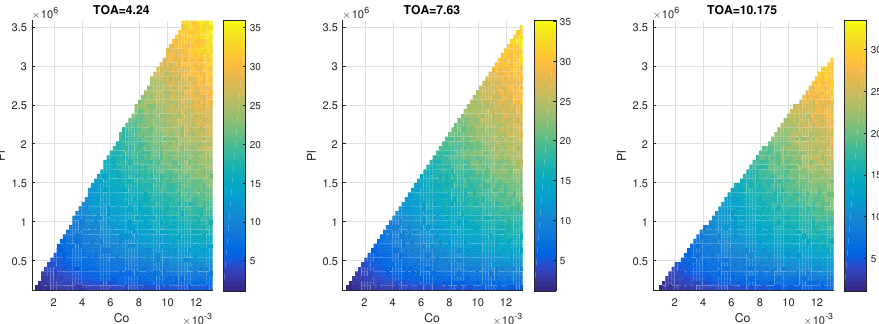
Figure 6. Frequency of oscillations as a function of Co and Pl for different values of TOA .